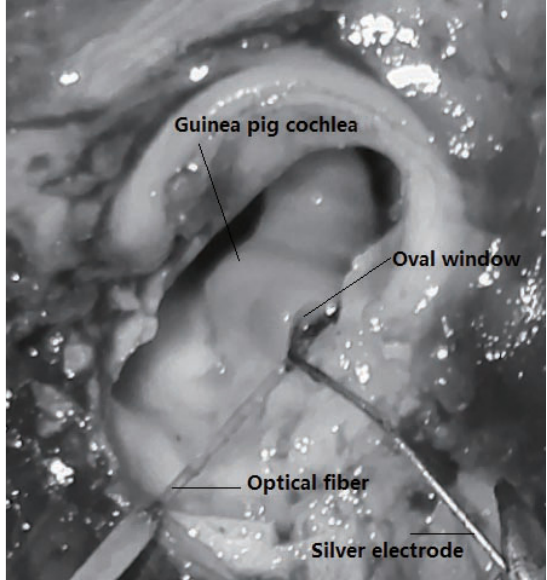
Fig. 2. Relative location among the optical ¯ber, silver electrode and